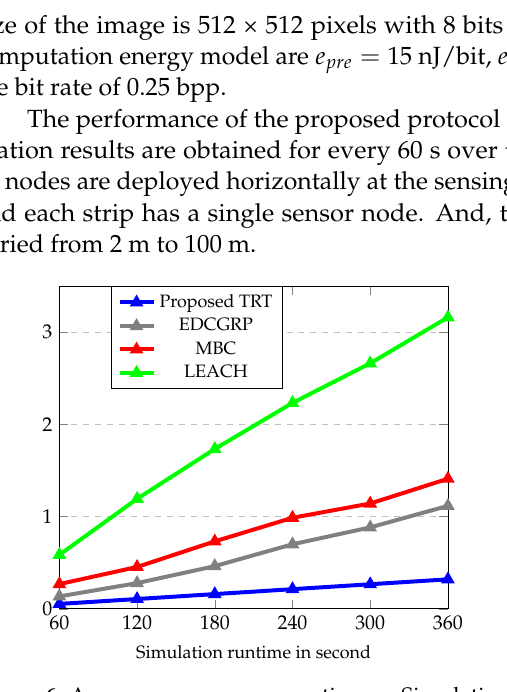
Figure 6. Average energy consumption vs. Simulation runtime.